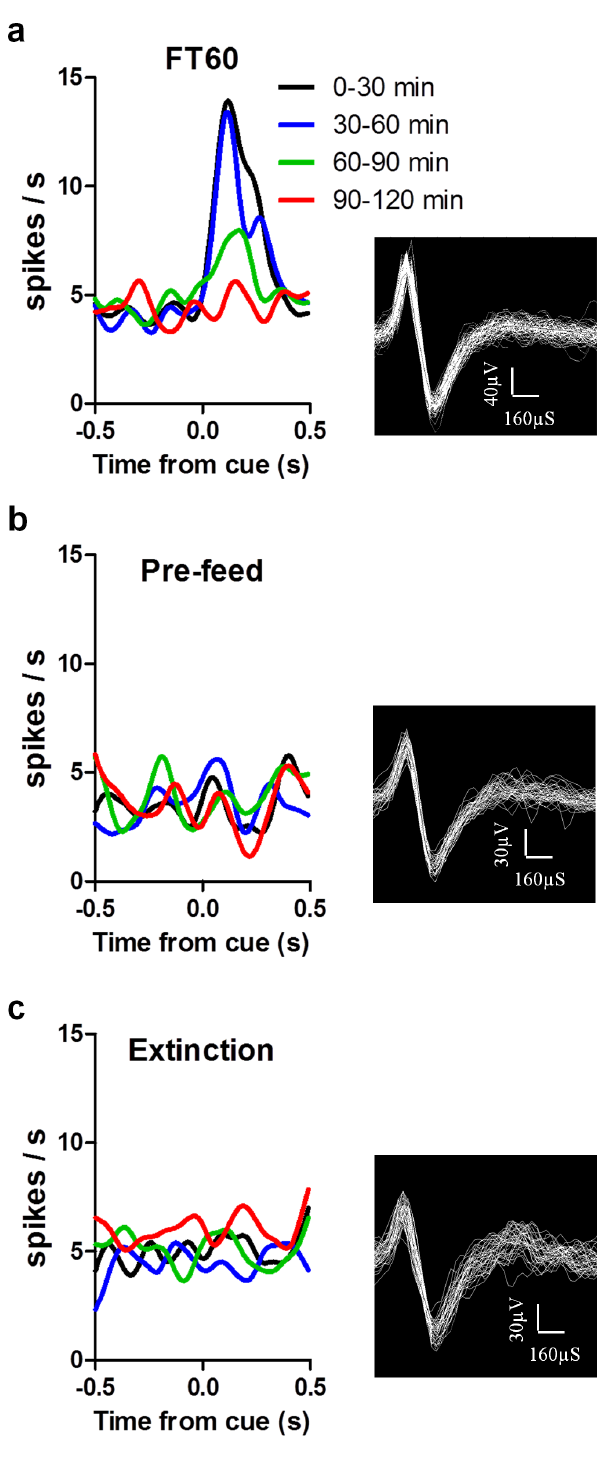
Figure 10. Motivational modulation is absent following pre- feeding and during extinction. of the response of a dopamine neuron to the cue in FT60 ( a ), pre-feed ( b ), and extinction ( c ) sessions. Each line represents the average response from a 30-trial block. Bins =10 ms, Gaussian smooth =100 ms. Corresponding waveforms are shown at the